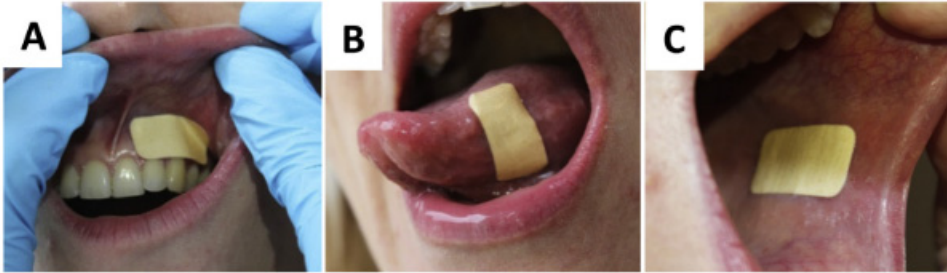
Figure 4. Mucoadhesive Rivelin ® patches placed on the ( A ) gingiva, ( B ) lateral tongue, ( C ) buccal mucosa of a healthy human volunteer. Reproduced from Biomaterials 2018 , 178 , 134–146.